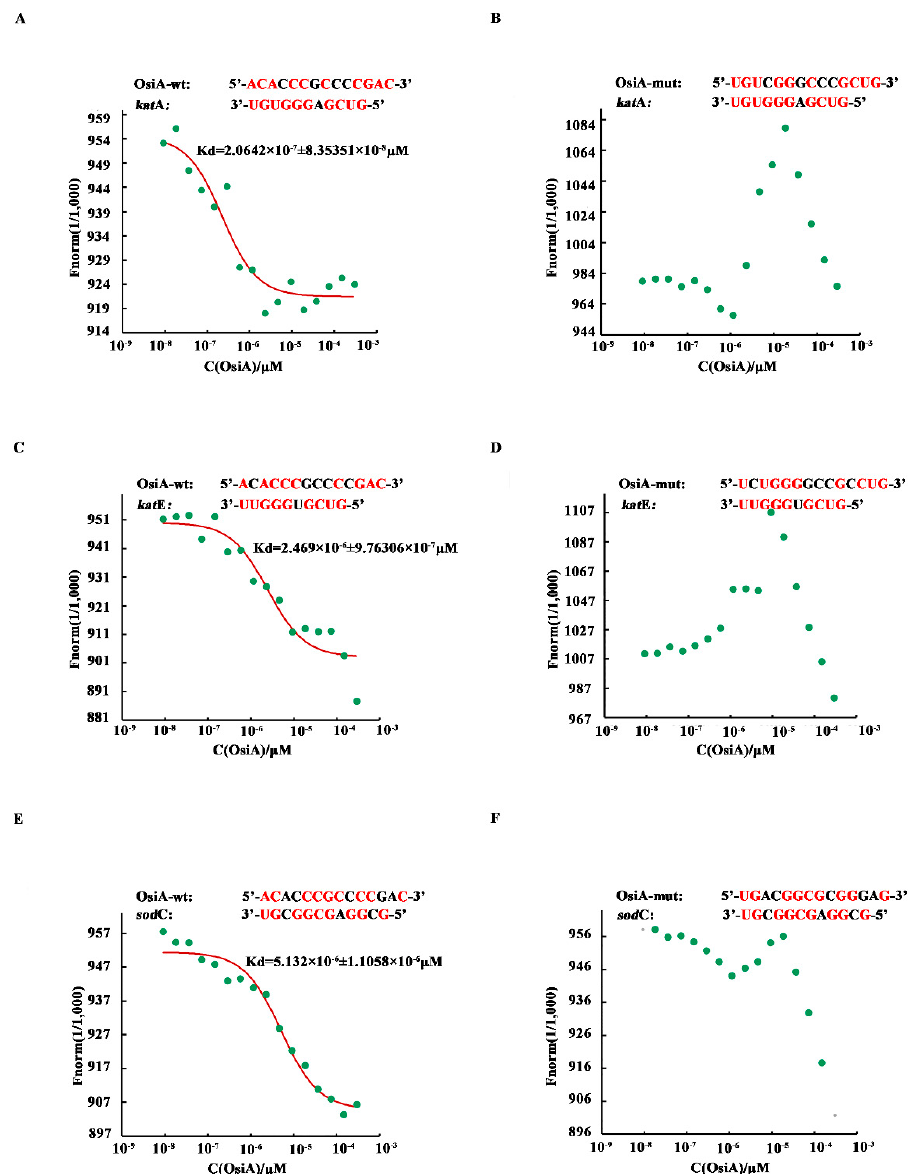
Figure 3. Microscale thermophoresis of selected sRNAs and their target genes. Red bases mean complementary bases in the binding sequence, the red curve is the fitted combination curve, and the Kd (dissociation equilibrium constant) value is the binding constant of sRNAs and their targets. ( A , C , E ) are the binding of dr_1998 ( katA ) mRNA, dr_A0202 ( sodC ) mRNA, and dr_A0259 ( katE ) mRNA, respectively, with OsiA-wt. ( B , D , F ) are the binding of dr_1998 mRNA, dr_A0202 mRNA, dr_A0259 mRNA, respectively, with OsiA-mut.